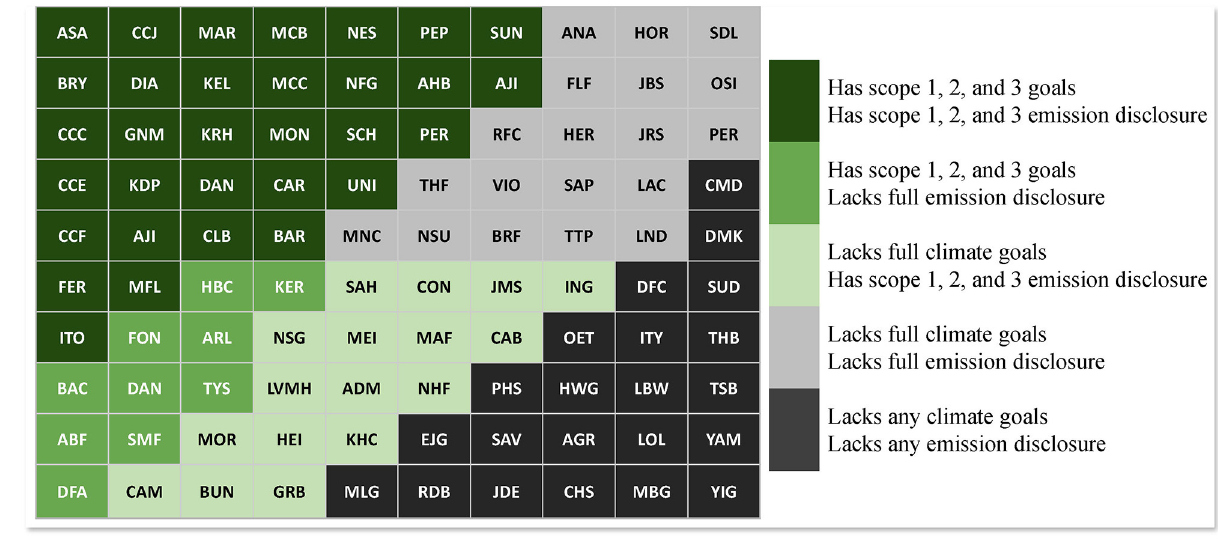
FIGURE 2 | Heat map showing the current status of climate goals and greenhouse gas emission disclosure of top 100 global food and beverage companies as ranked by Food Engineering (Food Engineering, 2020). The data were taken from 2020 CDP or corporate reports. Each box contains an abbreviation for one company, company abbreviations can be found in Supplementary Table S1